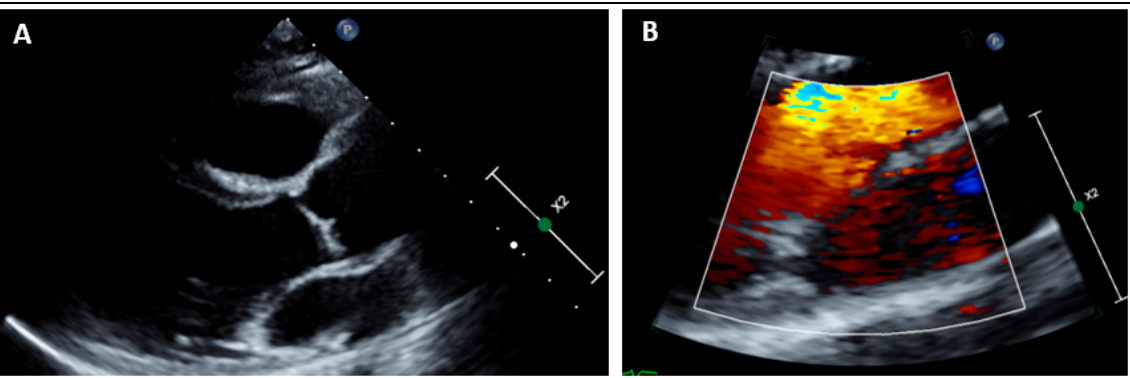
5 of 10 Figure 3. Family pedigree and integrative genomics viewer visualization showing the p.(Ala572Asp) and p.(His558Arg) in the SCN5A gene. Both symptomatic family members (I-2 and II-2) carried the two variants. The father